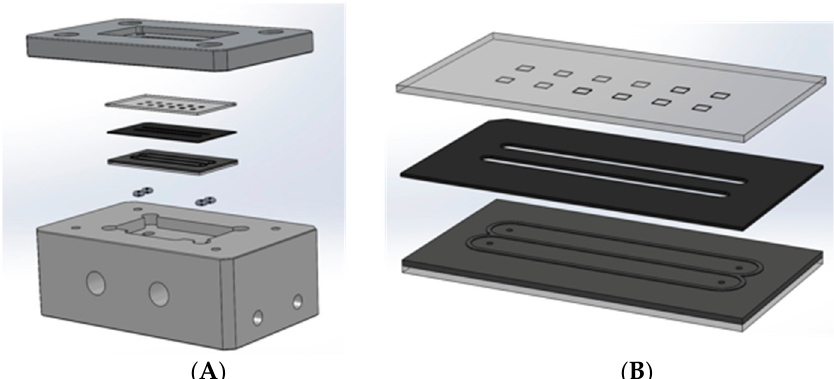
Figure 3. Design of the flow-cell of the fluidic system. ( A ) An exploded view, showing (from top to bottom) the chipholders lid, the sensing chip (BICELLs facing down), a gasket defining the flow-cell, the fluidic chip, O-rings for the seal between chip and the chipholder body, providing standard connections to the outside world. ( B ) Close-up from the three main parts defining the actual flow-cell: Sensing chip, gasket and fluidic chip (from top to bottom).